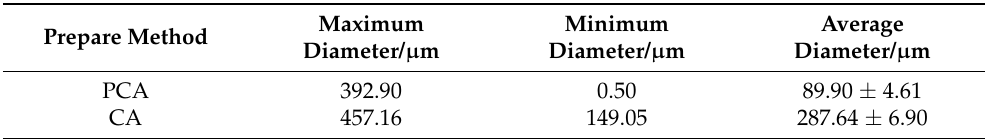
Table 2. The diameters of two kinds of ca-alginate